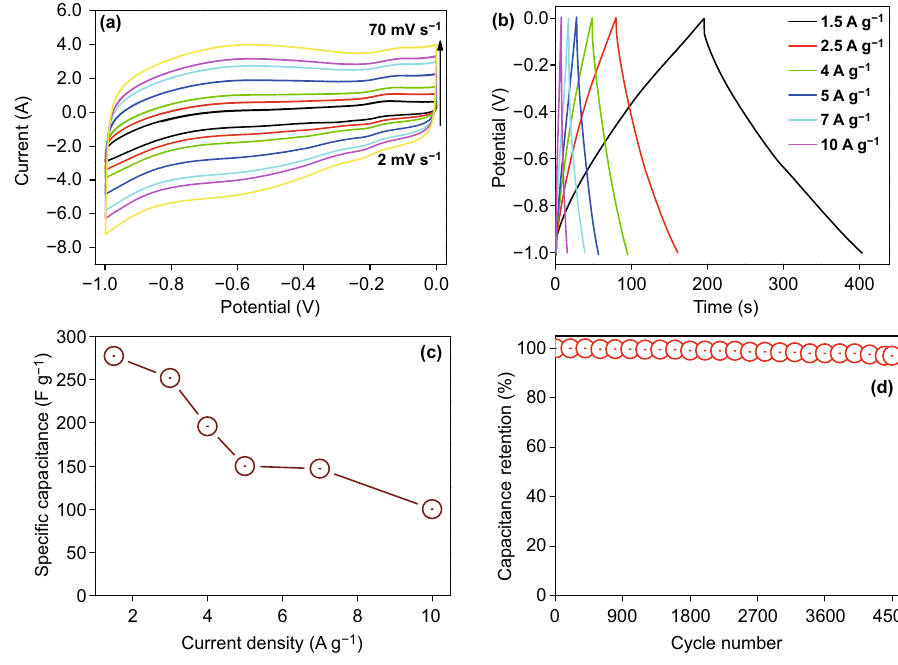
Fig. 6 a CV, b GCD, c specific capacitance at different current loads, and d cyclic stability of the rP@rGO